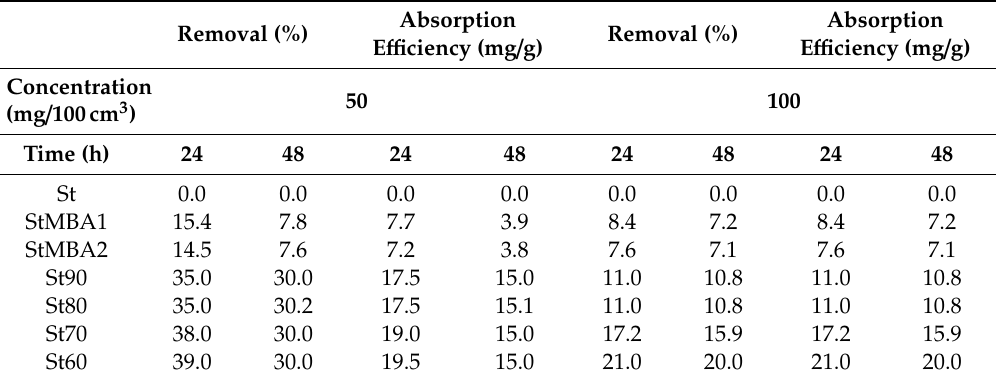
Figure 7. The removal of Cu(II) (%) and adsorption efficiency (mg Cu(II)/g) in time of initial concentration 50 Cu(II) mg/100 cm 3 ( a ) for St, StMBA1 and StMBA2; ( b ) for starch SAPs with different amount of natural polymer; for initial concentration 100 Cu(II) mg/100 cm 3 ( c ) for St, StMBA1 and StMBA2; ( d ) and for starch SAPs. for starch SAPs. Table 1. The removal of Cu(II) (%) and adsorption e ffi ciency [mg Cu(II) / g] after 24 and 48 h from two initial concentration of Cu(II) for St, StMBAs and starch SAPs with di ff erent amount of